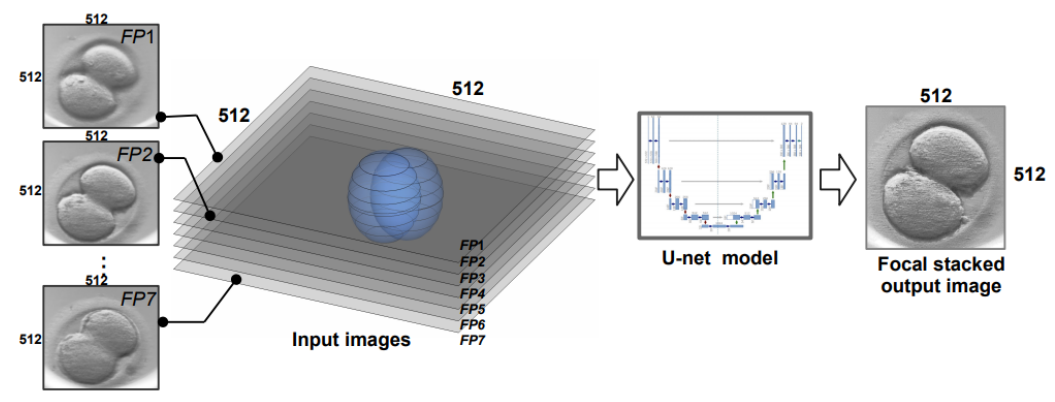
Figure 3. Functional diagram of multi-focal image fusion